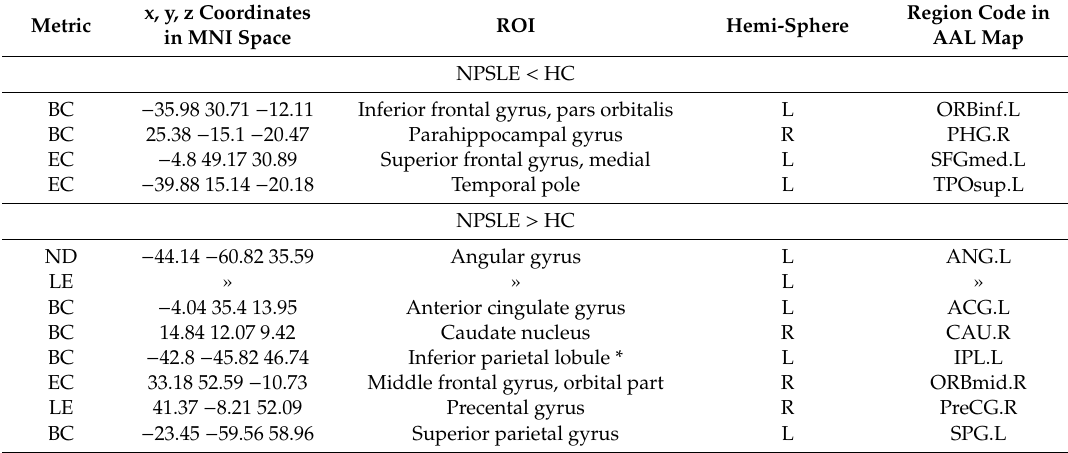
Table3. Mostsignificantfeaturesassociatedwiththebest-performingclassificationmodeldi ff erentiating NPSLE patients from healthy controls